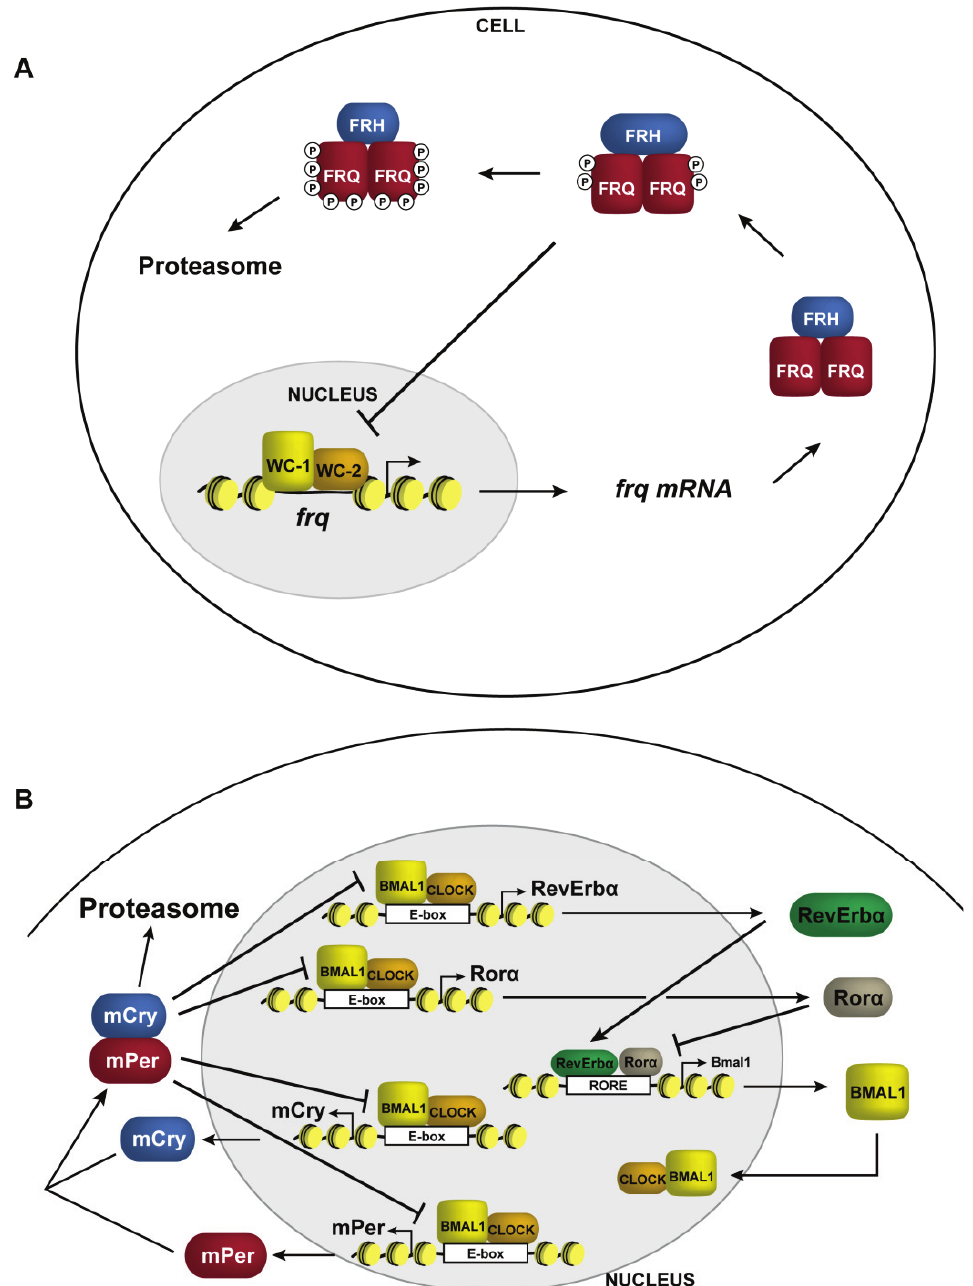
Figure 1. Transcriptional negative feedback in the clock. Schematic representation of circadian negative feedback in ( A ) Neurospora and ( B ) mammals. The negative elements are shown in red (FRQ and mPer) and blue (FRH and mCry), and the positive elements are shown in yellow (WC-1 and BMAL1) and orange (WC-2 and CLOCK). For simplicity, only a single Per gene and single Cry gene were included. Rorα and Rev- Erbα , which form a second interconnect loop in mammals regulating rhythms in Bmal1 expression, are shown in beige and green,